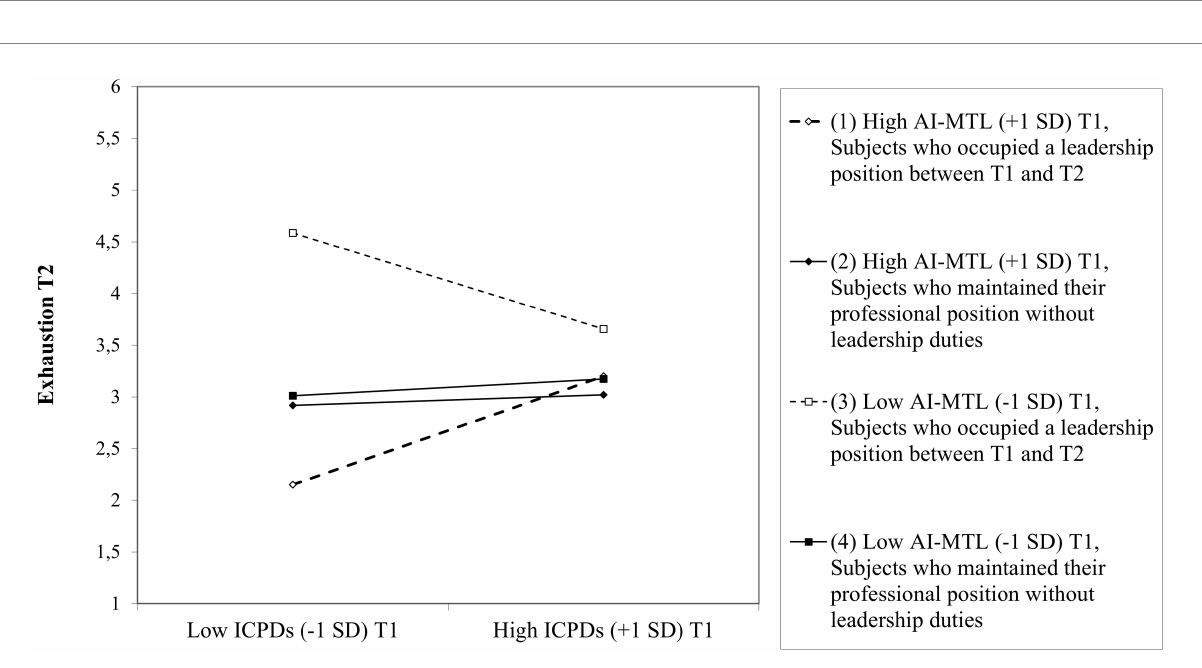
FIGURE 4 Three-way interaction effect between affective-identity motivation to lead (AI-MTL) at T1, intensified career-related planning demands (ICPDs) at T1 and leadership status on exhaustion at T2 ( B coefficients are reported in the text).